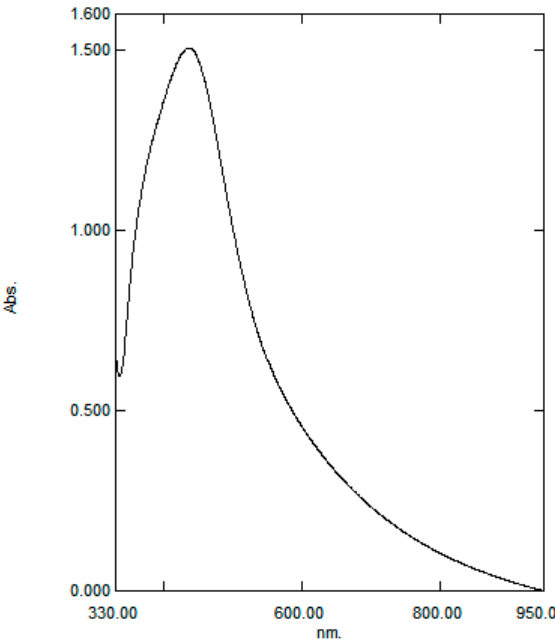
Figure 1. UV-vis absorbance spectra of AgNPs prepared with aqueous A.nilotica pod extract.